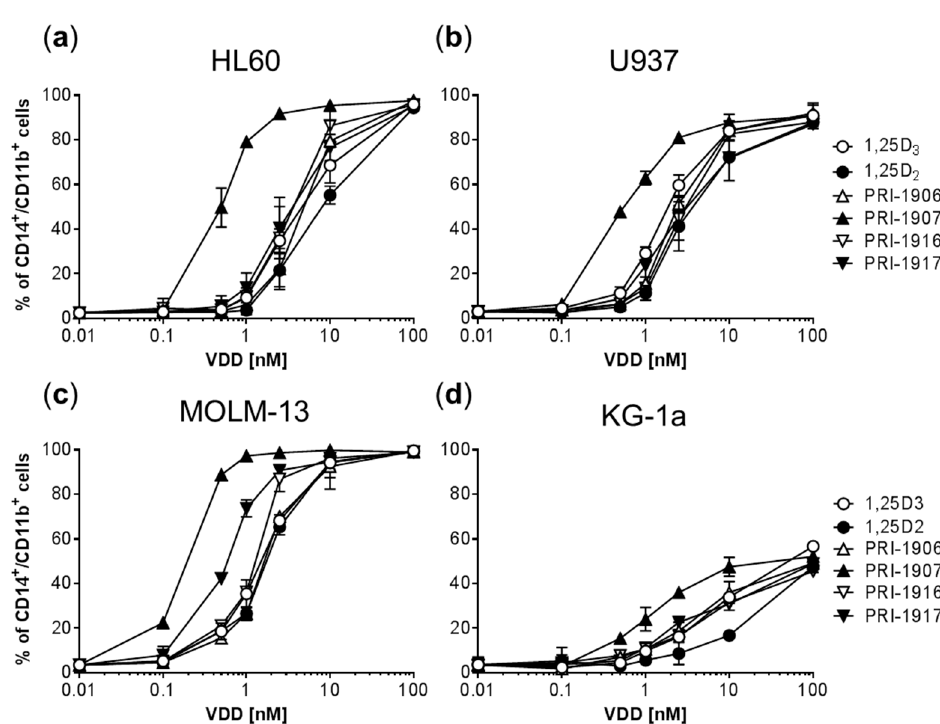
Figure 3. Comparison of the differentiation-inducing effects of different vitamin D derivatives on AML cells. ( a – d ) Cells were incubated with the indicated agents or vehicle ( ≤ 0.2% ethanol) for 96 h. The expression of CD14 and CD11b was determined by flow cytometry. The percentage of the double-positive CD14 + /CD11b + cell population is presented. The data are the means ± SD of at least four independent experiments.